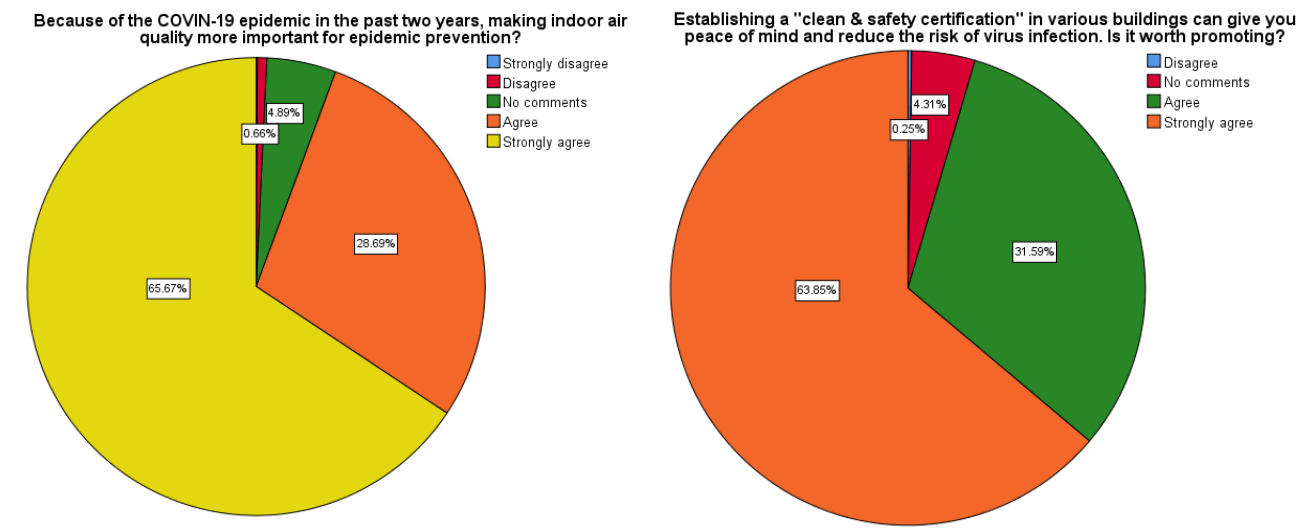
Figure 1. The importance of IAQ and the cognition of “ Clean and Safe ” certification.